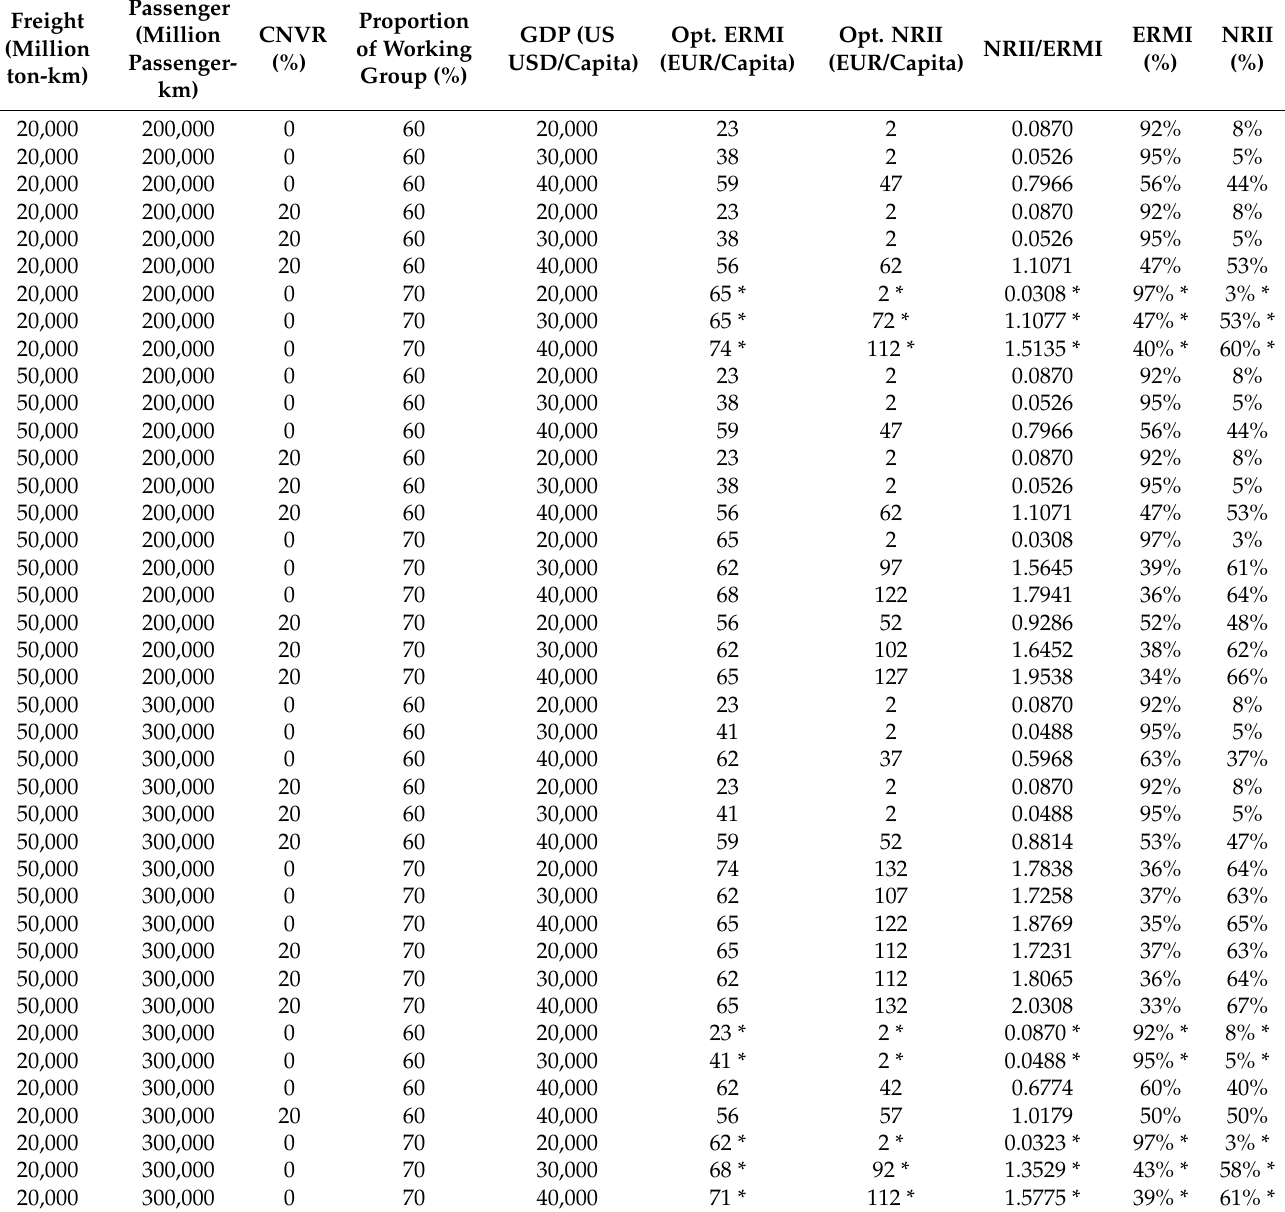
Table A3. Optimized annual ERMI and NRII for population of 30